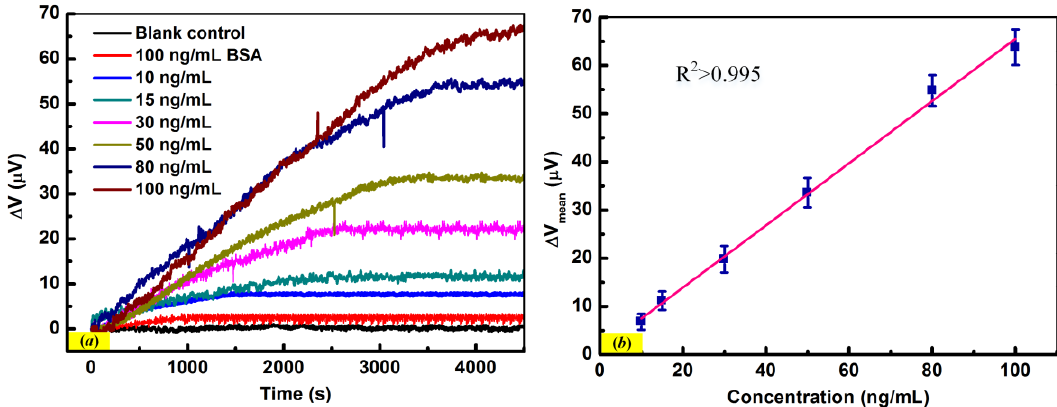
Figure 7. ( a ) The response curves of immunosensors detecting IgG with the concentrations of 10, 15, 30, 50, 80, and 100 ng/mL, respectively. ( b ) The steady-state output voltage of immunosensors versus the concentrations of IgG in PBS, which shows a linear relation with the goodness of fit (R 2 -value) above